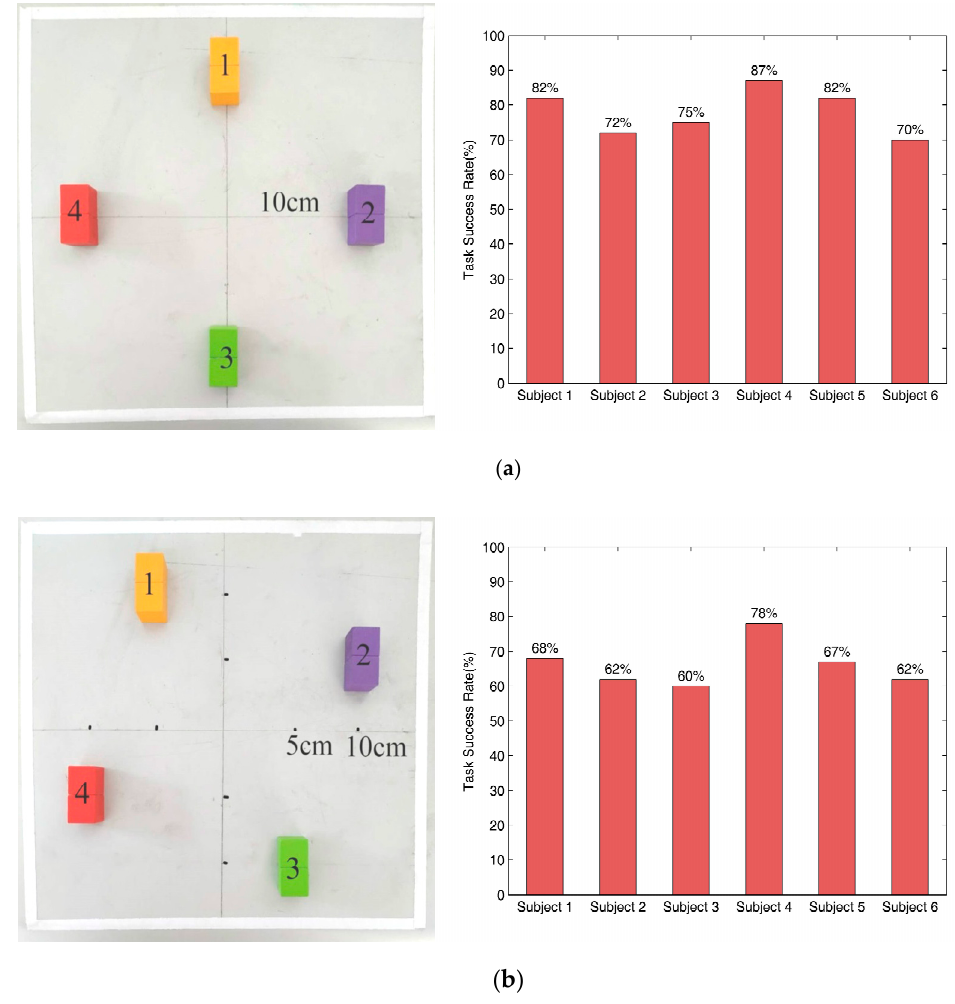
Figure 16. Task success rate of motor imagery EEG-based teleoperation robot system for online Task 1 ( a ) and online Task 2 ( b ).